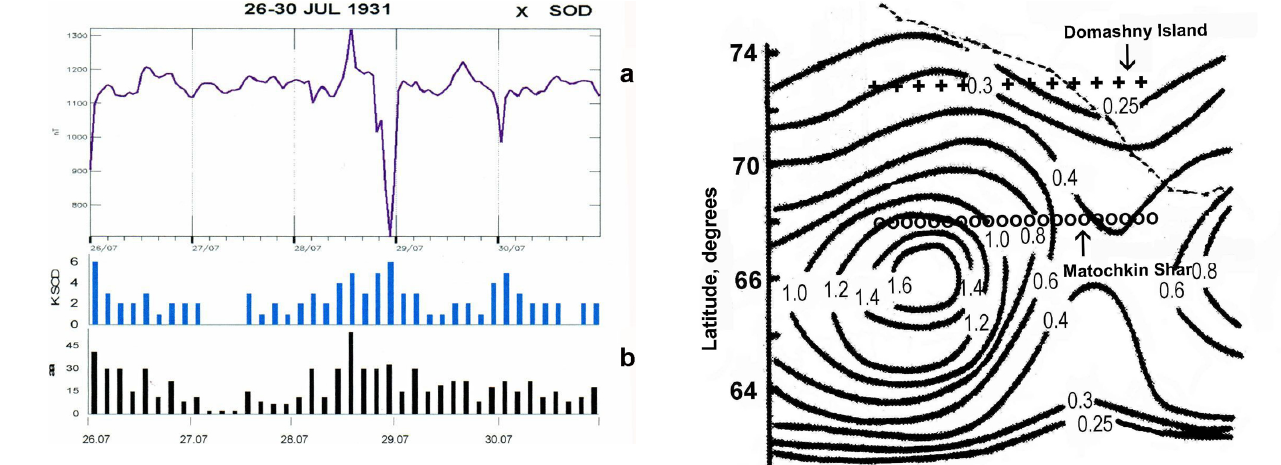
Figure 10. Magnetograms of the Sodankyl¨a Observatory: (a) – X - component for the time interval from 26 till 30 July 1931; (b) – vari- ations in K indexes of the Sodankyl¨a Observatory and aa -indexes (in nT) for the time interval from 26 till 30 July 1931. Figure 11. Averaged picture of distribution of auroral absorption